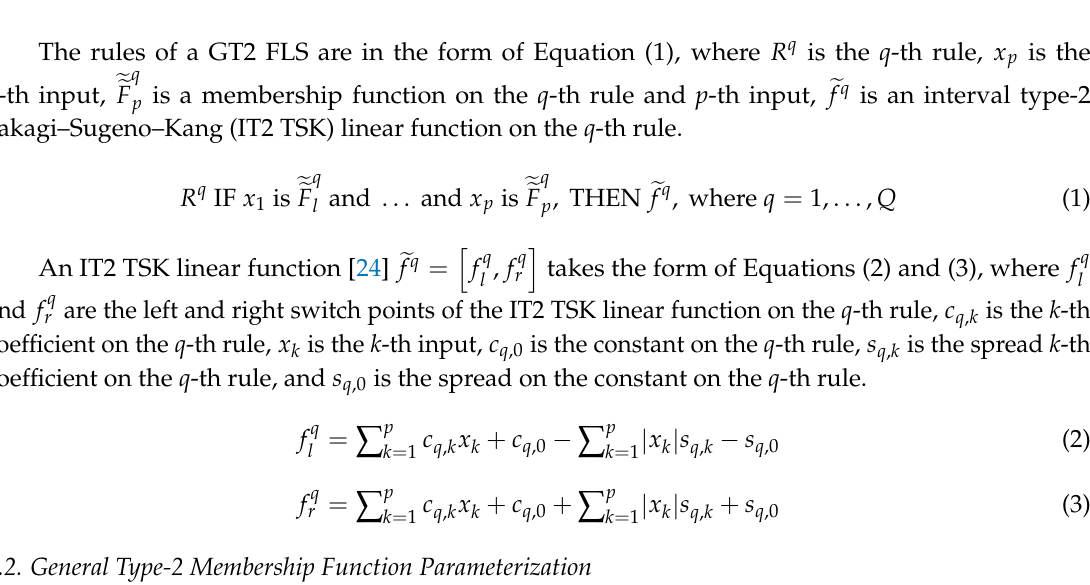
Figure 2. Generic GT2 FS as shown from an isometric view.